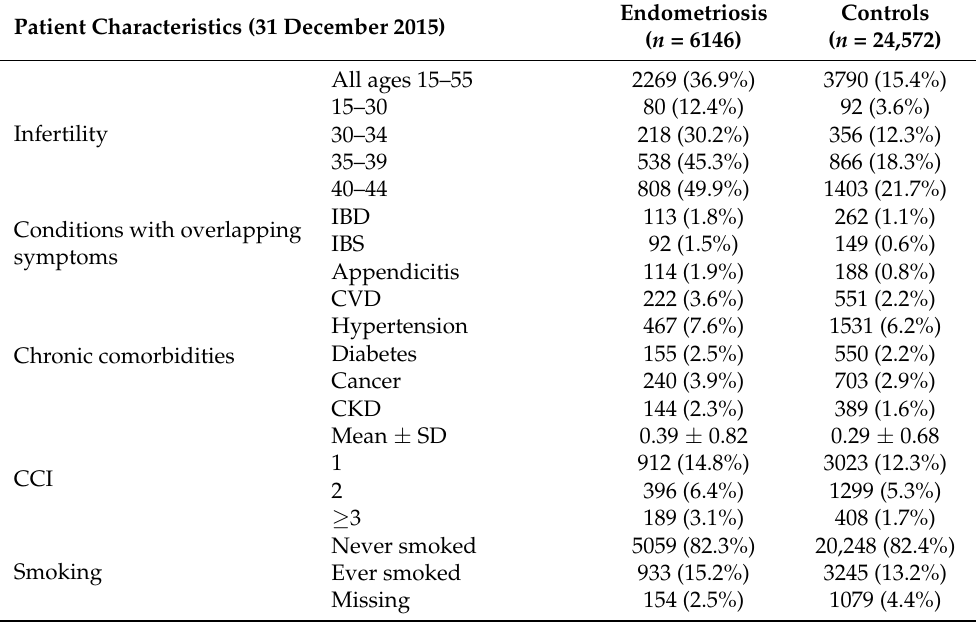
Table 2. Comorbidities among women diagnosed with endometriosis compared to matched